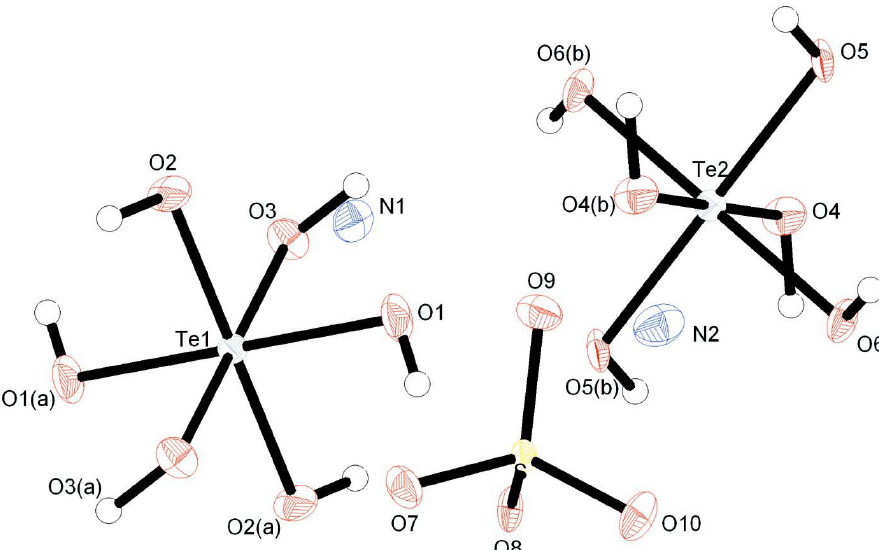
Figure 2 A part of the structure of Na [Symmetry codes:( a ) - x + 1,- y , - z ; ( b ) - x , - y + 1, - z